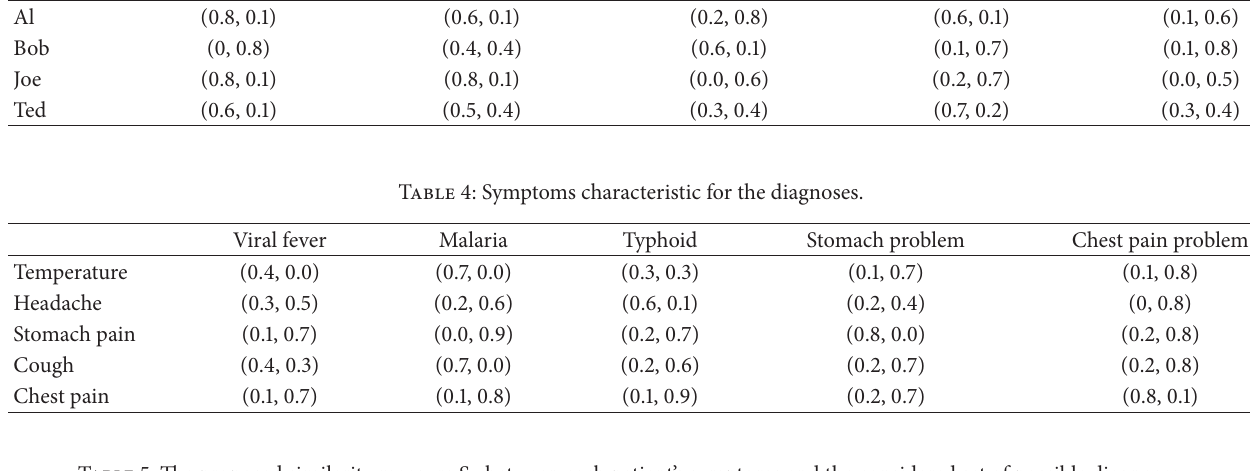
Table 5: The proposed similarity measure 𝑆 𝑌 between each patient’s symptoms and the considered set of possible